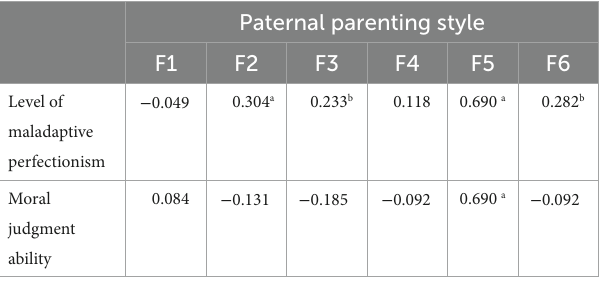
TABLE 2 Comparison of EMBU, FMPS-C, and MJT Chinese standard edition scores between the two groups (scores).